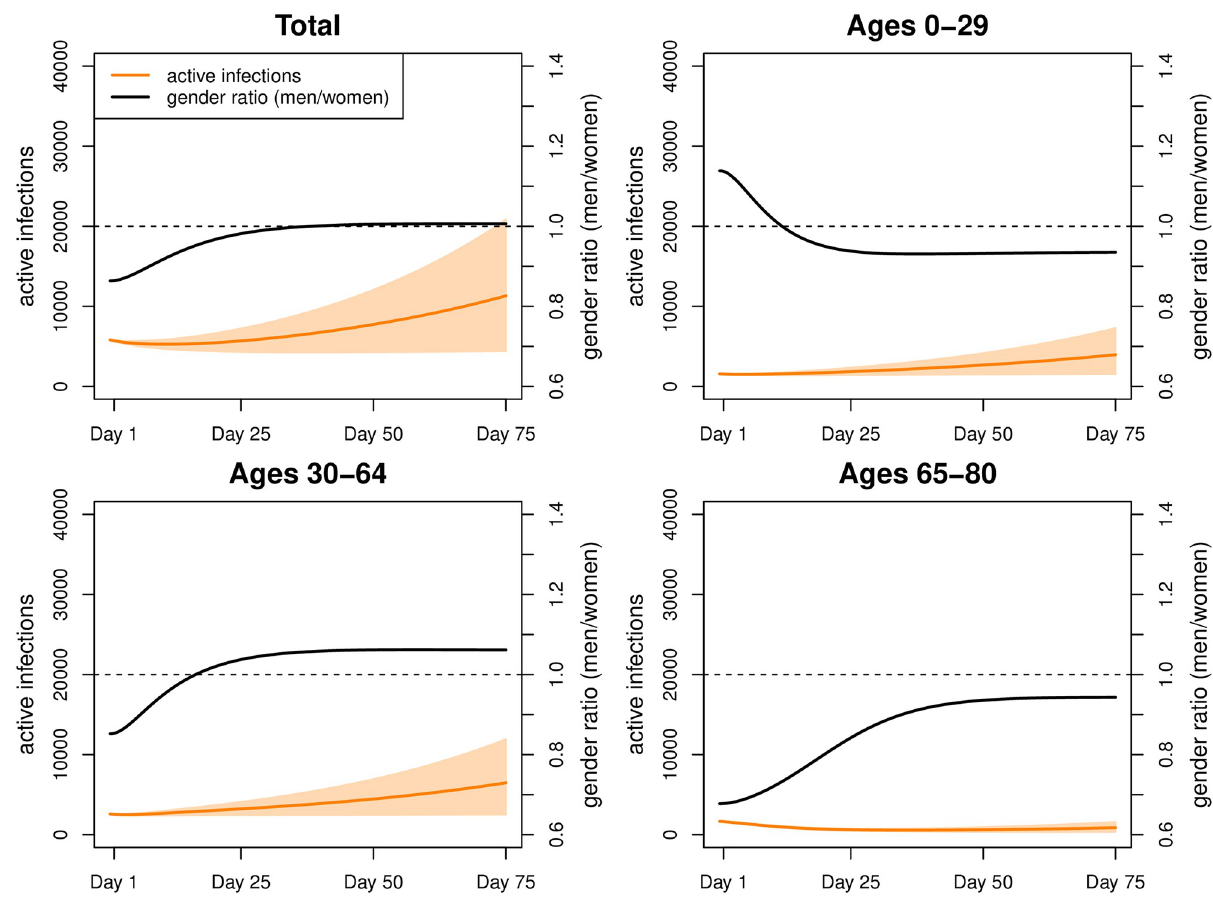
Fig 7. Simulation results for Scenario 2. Number of active infections and gender ratio (men/women) in Scenario 2 (intervals represent 80% range due to parameter uncertainty).